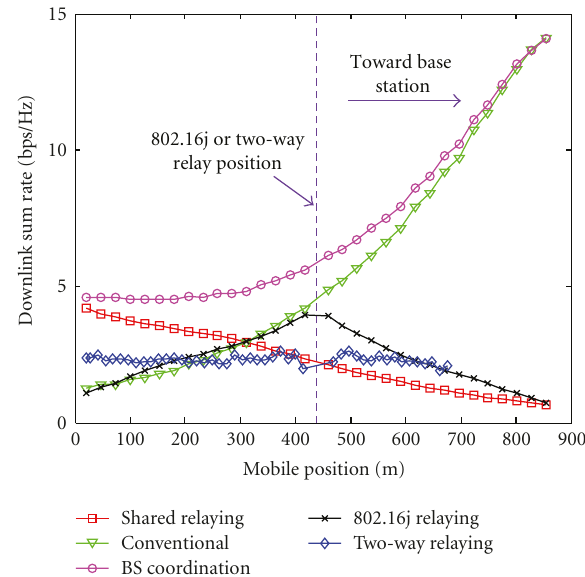
Figure 12: Downlink sum rate of two-way relaying and other strategies versus MS position relative to cell edge. The relay station is located 440 m from the base station.